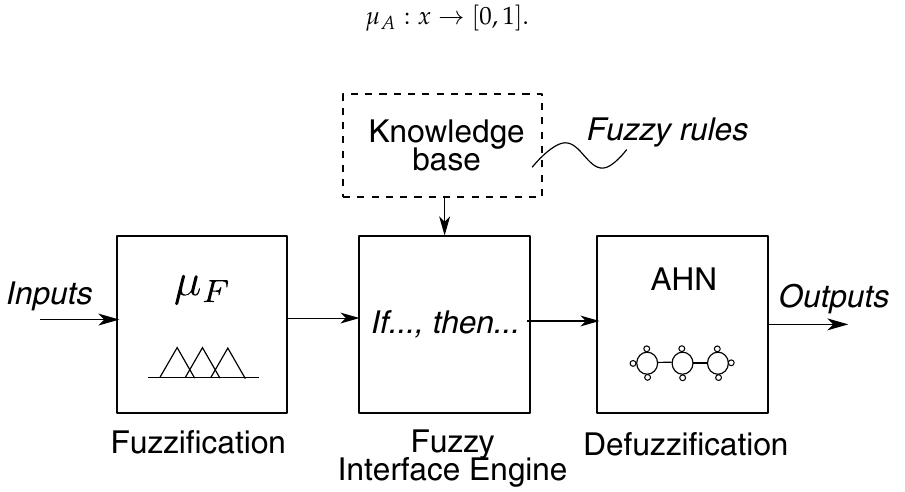
Figure 2. Block diagram of fuzzy-molecular interface